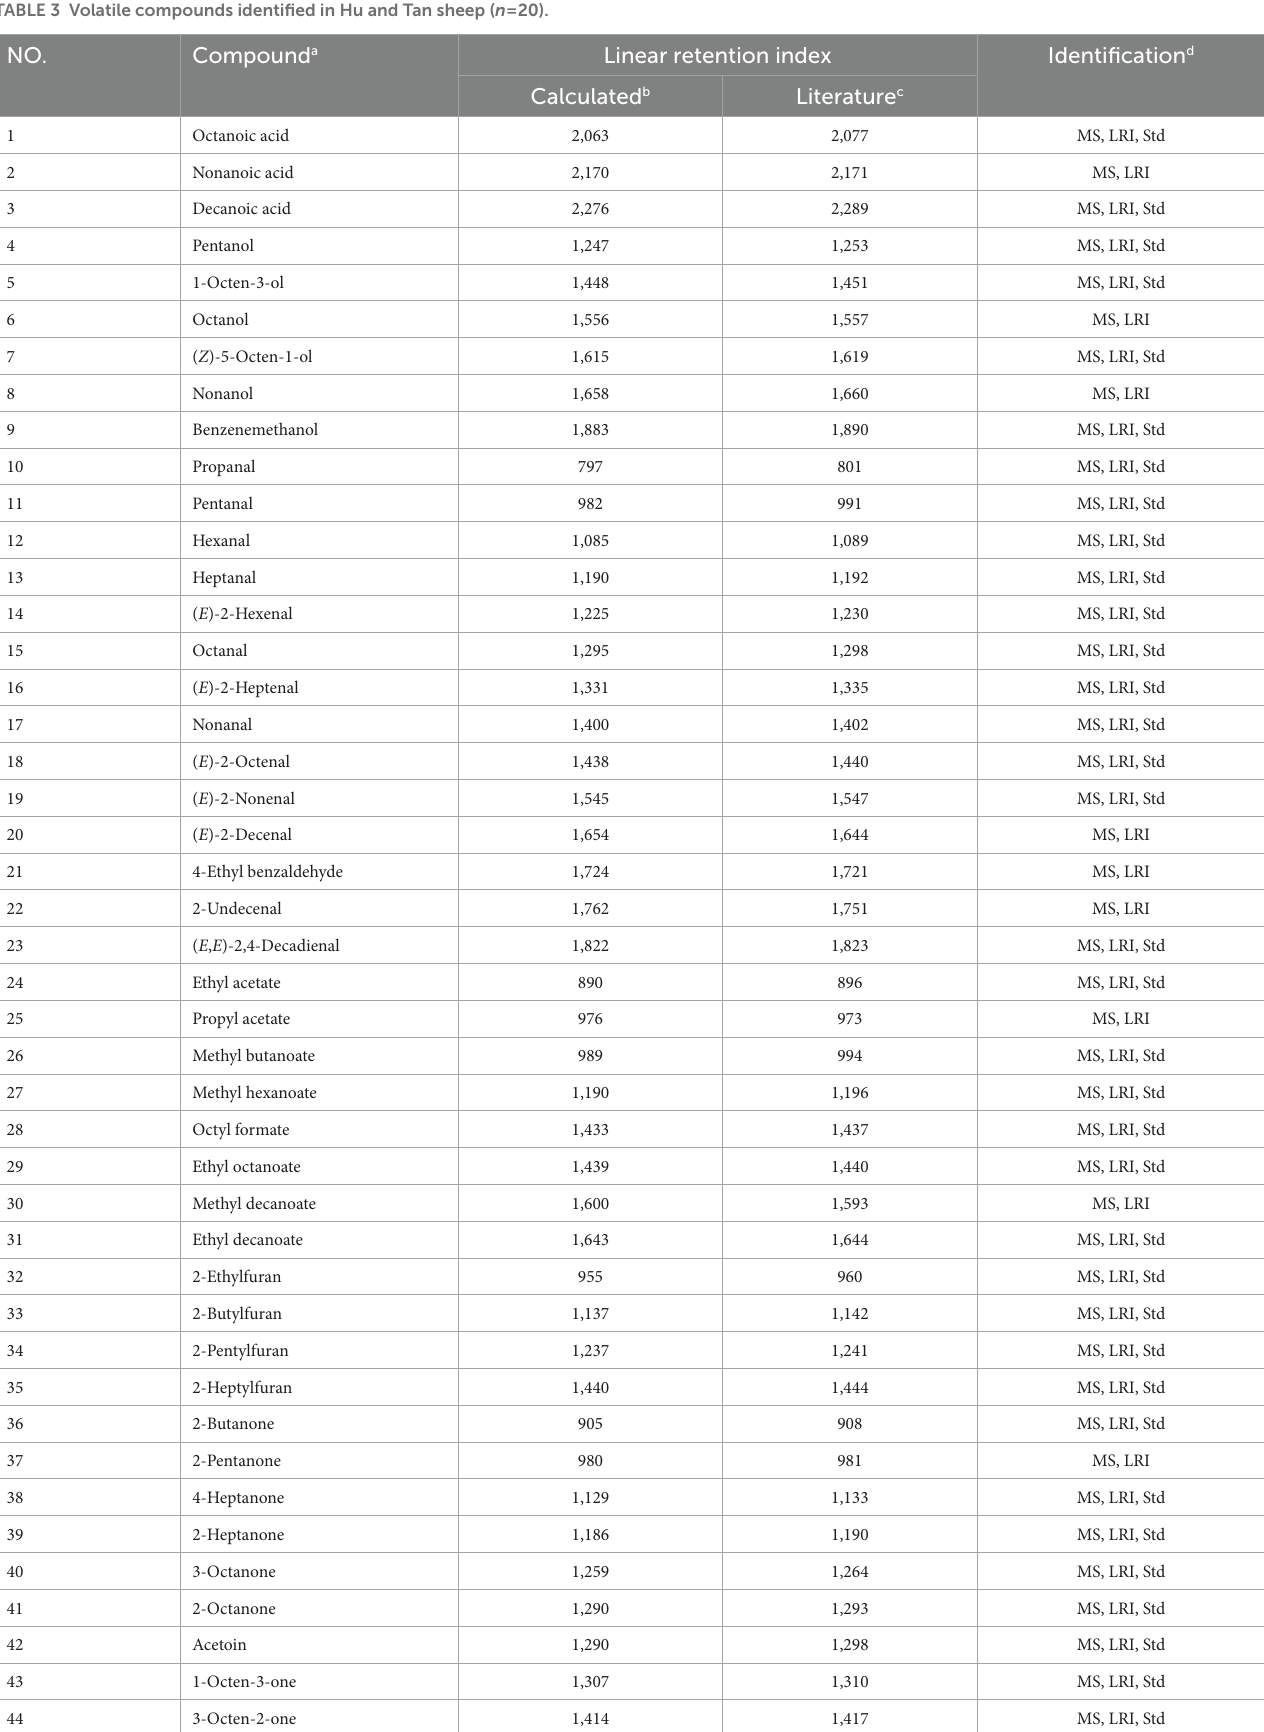
TABLE 3 Volatile compounds identified in Hu and Tan sheep ( n = 20).